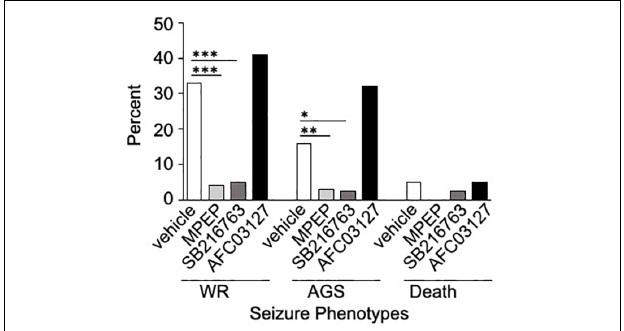
FIGURE 2 | SB216763 but not AFC03127 inhibits AGS in Fmr1 KO mice. Fmr1 KO mice were treated with 0.5% HPMC vehicle, 30 mg/kg MPEP, 30 mg/kg SB216763, or 10 mg/kg AFC03127 I.P. at P21 and 30 min later tested for susceptibility to wild running (WR), tonic-clonic seizures (AGS), and death in the AGS assay. Treatment groups were compared to vehicle by Fisher’s exact test. There were a minimum of n = 22 mice per cohort [ n = 159 vehicle (72 female and 87 male), n = 69 mice MPEP (32 female and 37 male), n = 40 mice SB216763 (11 female and 29 male), and n = 22 mice AFC03127 (10 female and 12 male)]. Asterisks indicate statistical significance of p ≤ 0.0001 ( ∗∗∗ ), p ≤ 0.01 ( ∗∗ ), and p ≤ 0.05 ( ∗